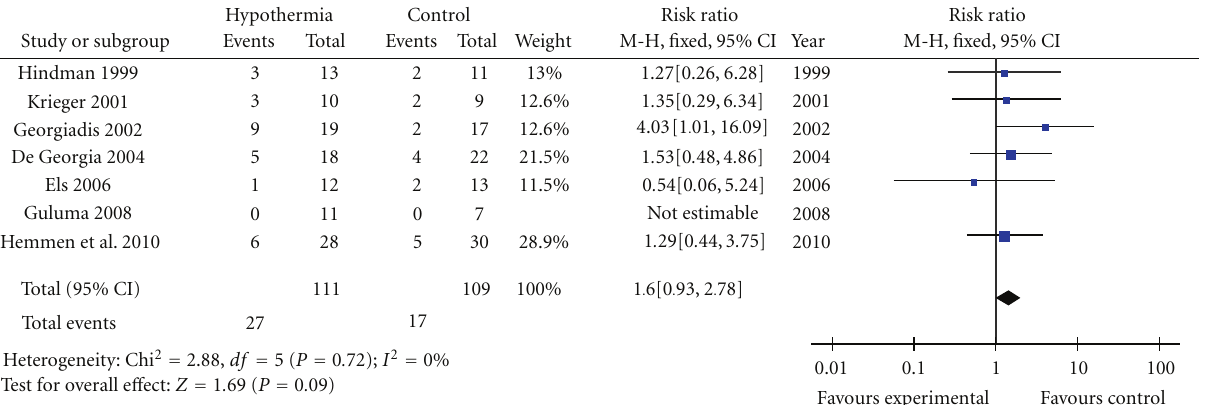
Heterogeneity: Chi 2 = 2.88, df = 5 ( P = 0 . 72); I 2 = 0% Test for overall e ff ect: Z = 1 . 69 ( P = 0 . 09) Figure 3: Forest plot illustrating the meta-analysis of the mortality rate presented in the controlled clinical trials of hypothermia and stroke.